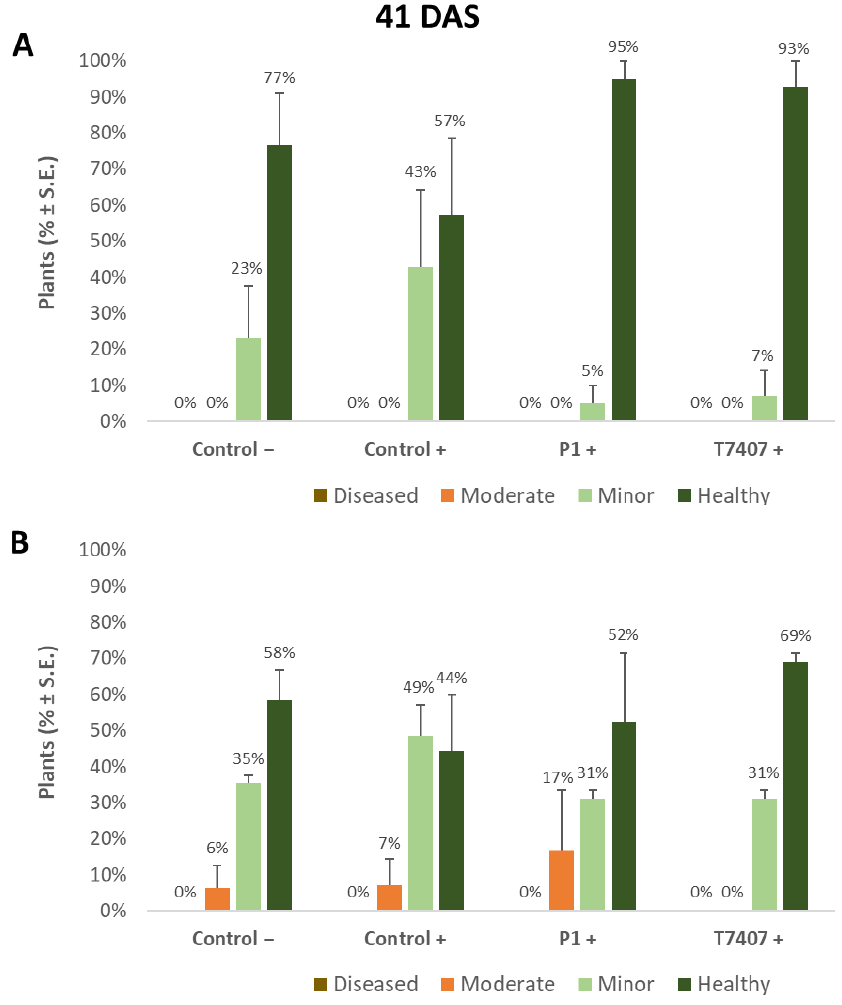
Figure 3. Quantitative evaluation of lower stem disease symptoms in the 2020 field experiment (41 DAS). ( A ). Stabbing-free treatments. ( B ). Stabbing inoculation treatments. Categories are described in Figure 2. Control − are plots without a complementary inoculation. Control+ are plots with M. maydis complementary infection. The other treatments are infected plots with T. asperellum (P1) and T. longibrachiatum (T7407). The control − are stabbing plots wounded with clean, sterilized toothpicks. Values are calculated based on 10–23 plants in each treatment in at least two repeats. Deviation bars represent standard error. No statistical difference between the treatments or the treatments and controls could be identified using the one-way ANOVA